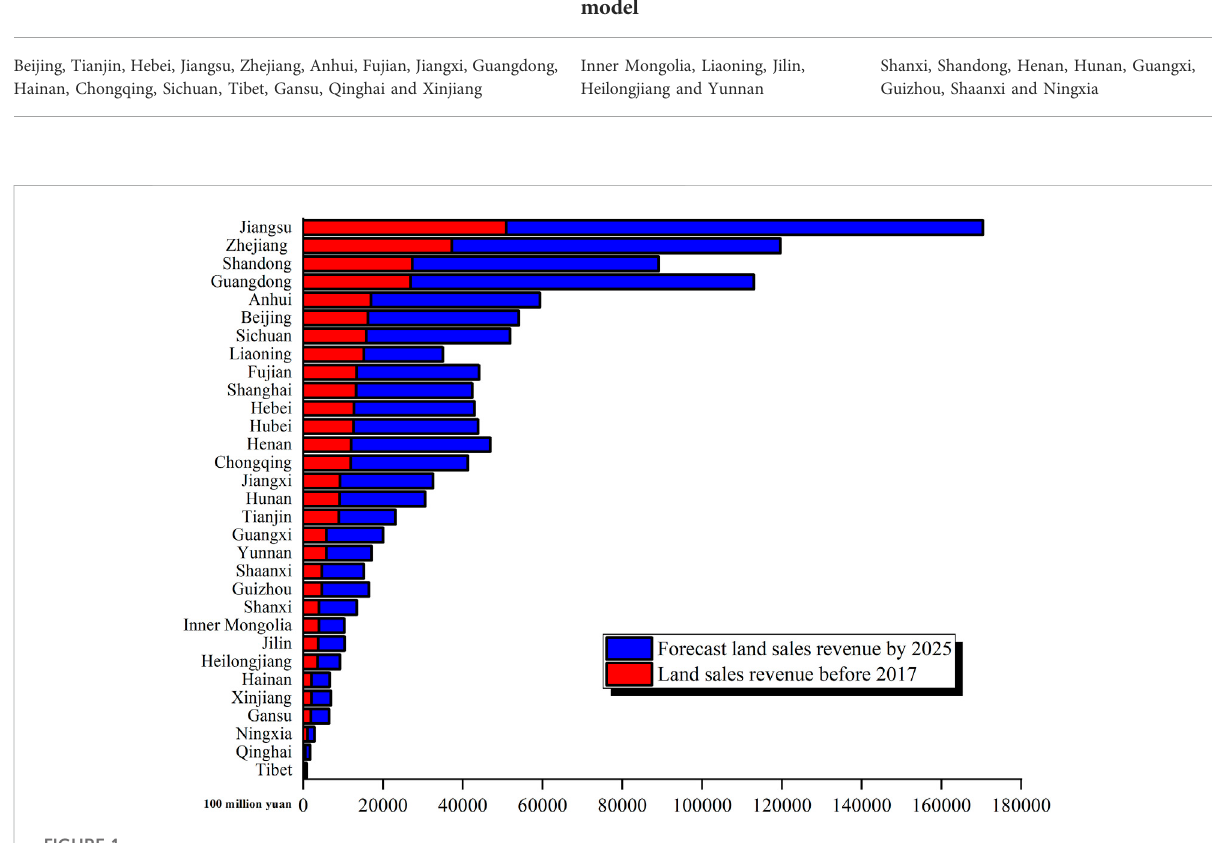
FIGURE 1 Previous and forecasted changes of land transfer income in the